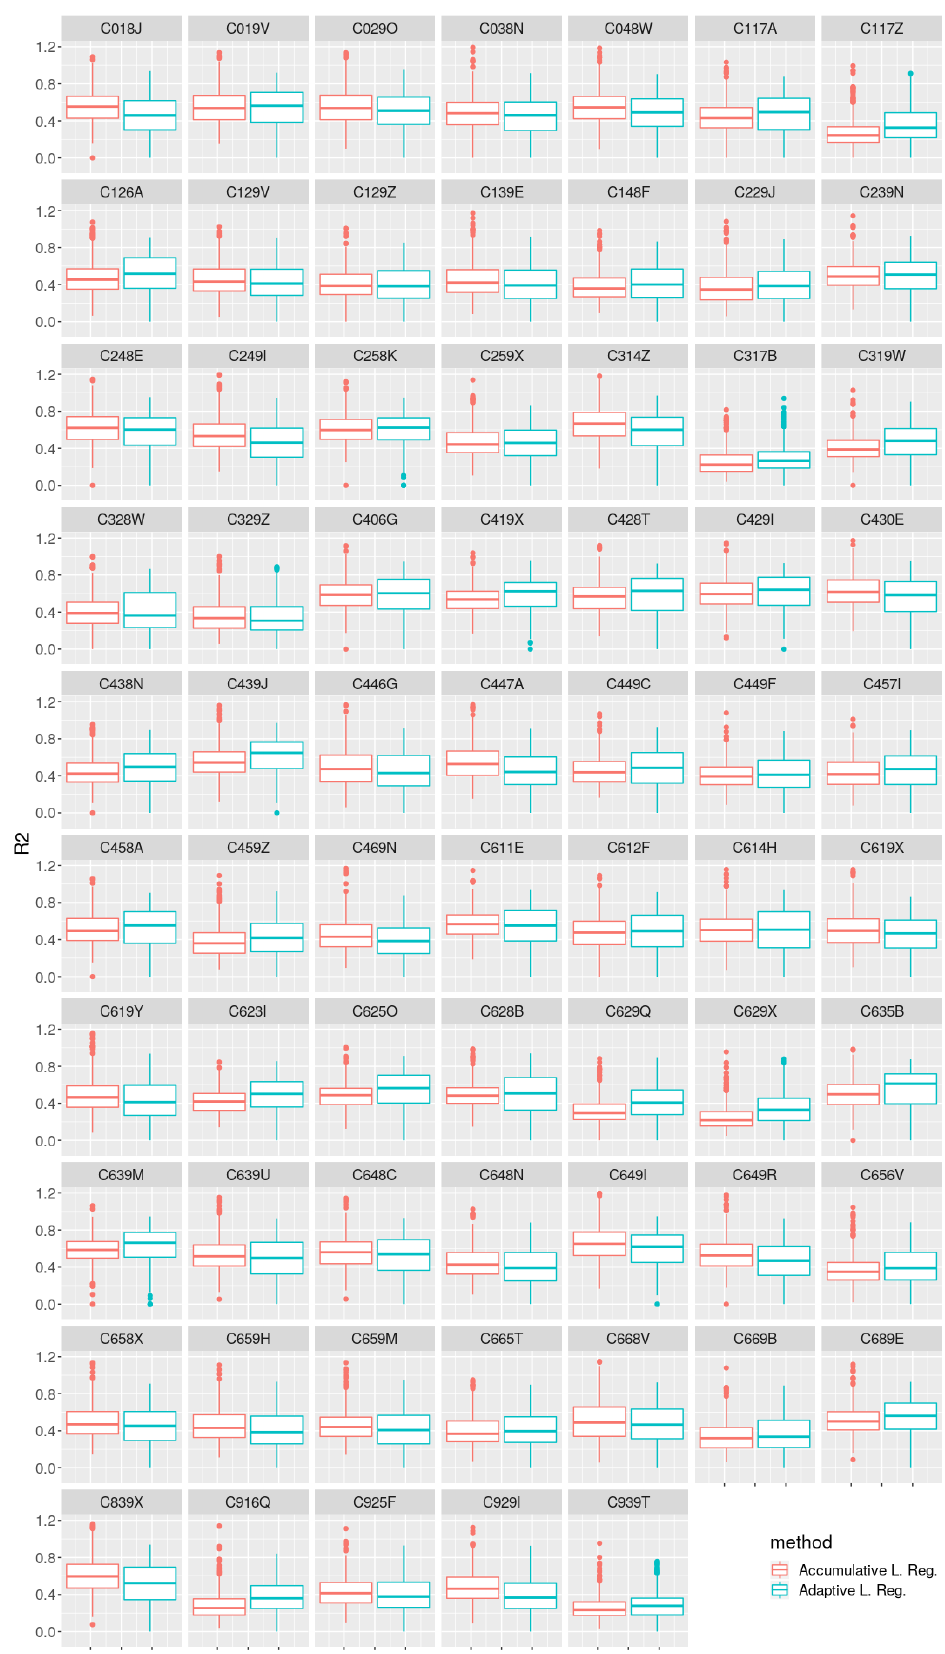
Figure 11. Coefficient of determination ( r 2 ) box-plot comparison between both methods for each weather